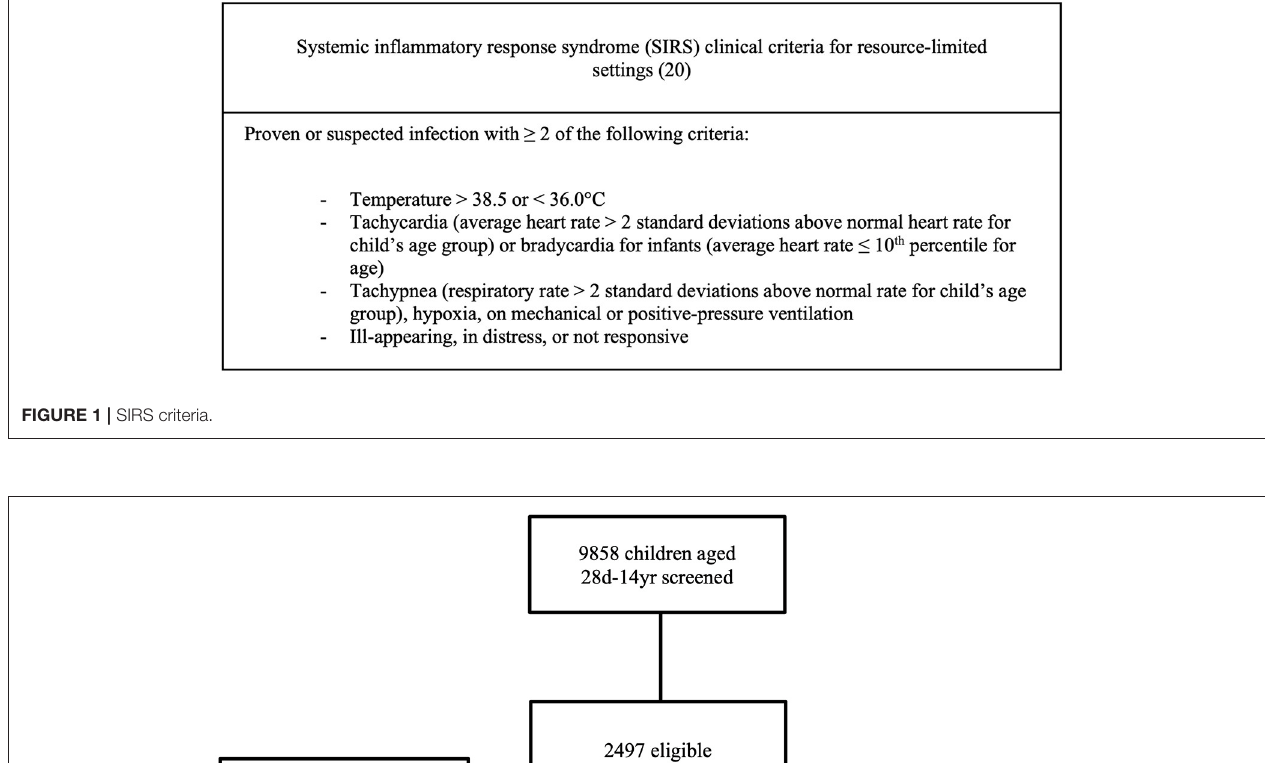
Frontiers in Pediatrics |